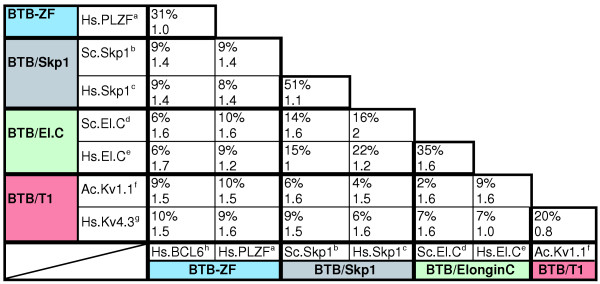
Pairwise sequence and structure comparisons of BTB structures. Cells contain the percentage identity and root mean square deviation (Å) value for each structure pair. Representative structures from the Protein Data Bank are labeled as follows: a1buo:A and 1cs3:A; b1nex:a; c1ldk:D, 1p22:b, 1fqv:B, 1fs1:B, 1fs2:B; d1hv2:a; e1vcb:B, 1lm8:C, 1lqb:B; f1a68:_, 1eod:A, 1eoe:A, 1eof:A, 1t1d:A, 1exb:E (rat Kv1.1); g1s1g:A; h1r28:A, 1r29:A, 1r2b:A. The T1 domains from Kv1.2, Kv3.1 and Kv4.2 were omitted for clarity. El.C, ElonginC. Ac, Aplysia californica; Hs, Homo sapiens; Sc, Saccharomyces cerevisiae.